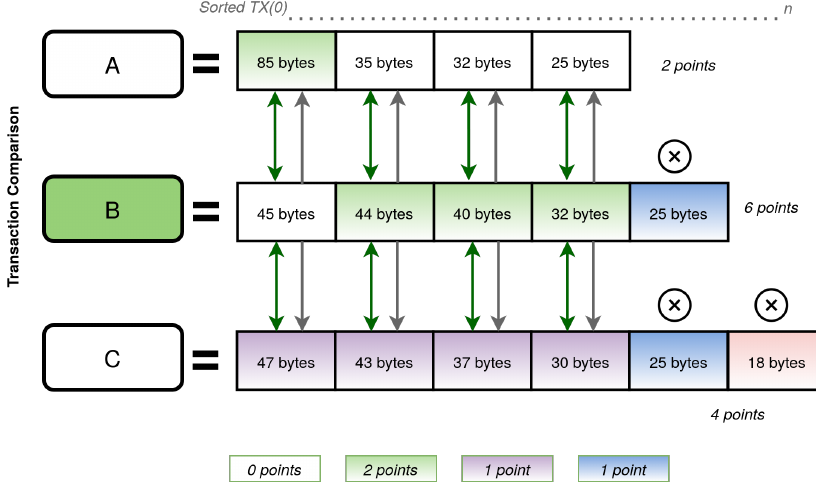
Figure 6. Sorting transactions to determine a block with most number of large-sized